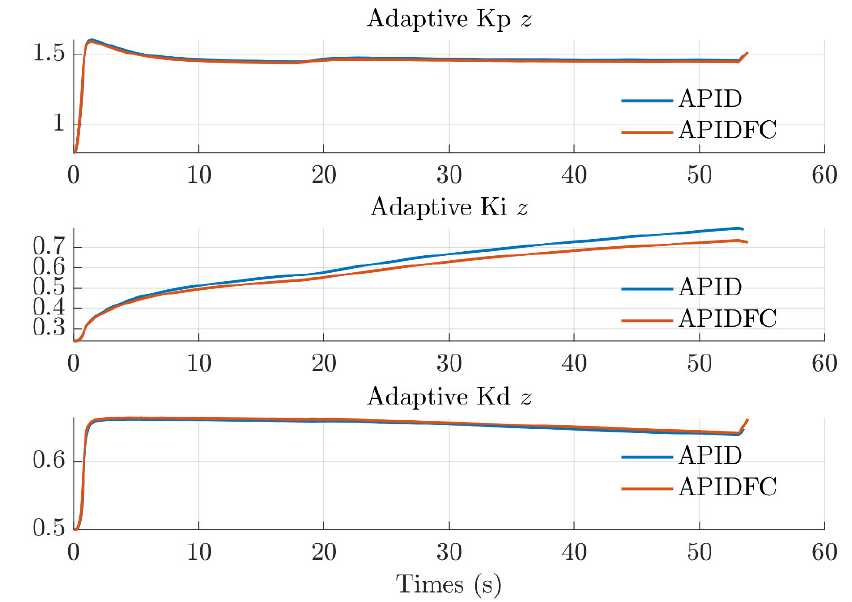
Figure 23. Adaptive parameter for altitude Z from the experiment.